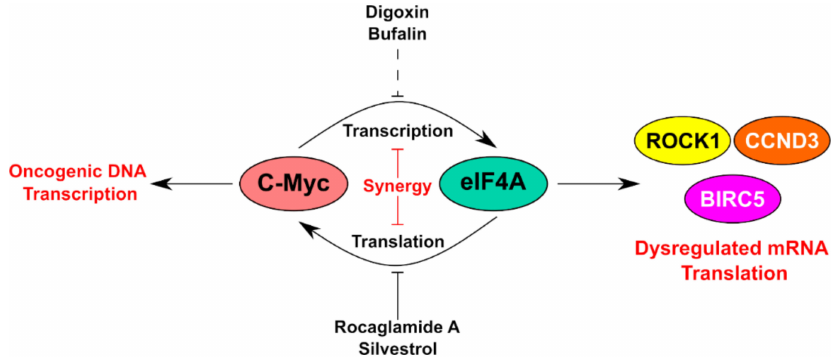
Figure 6. Proposed combinatorial targeting of eIF4A in TNBC cells. Inhibition of eIF4A, both directly and through modulation of upstream regulators (c-Myc), may prove synergistic as an anti-cancer therapy for triple-negative breast cancer